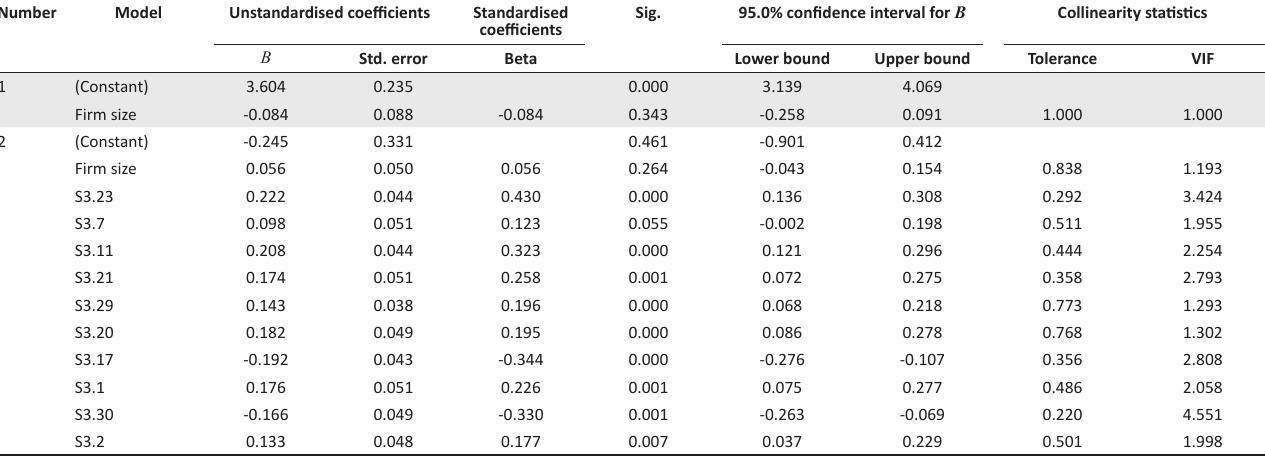
TABLE 5: Coefficients of organisational learning variables influencing risk management maturity. Number